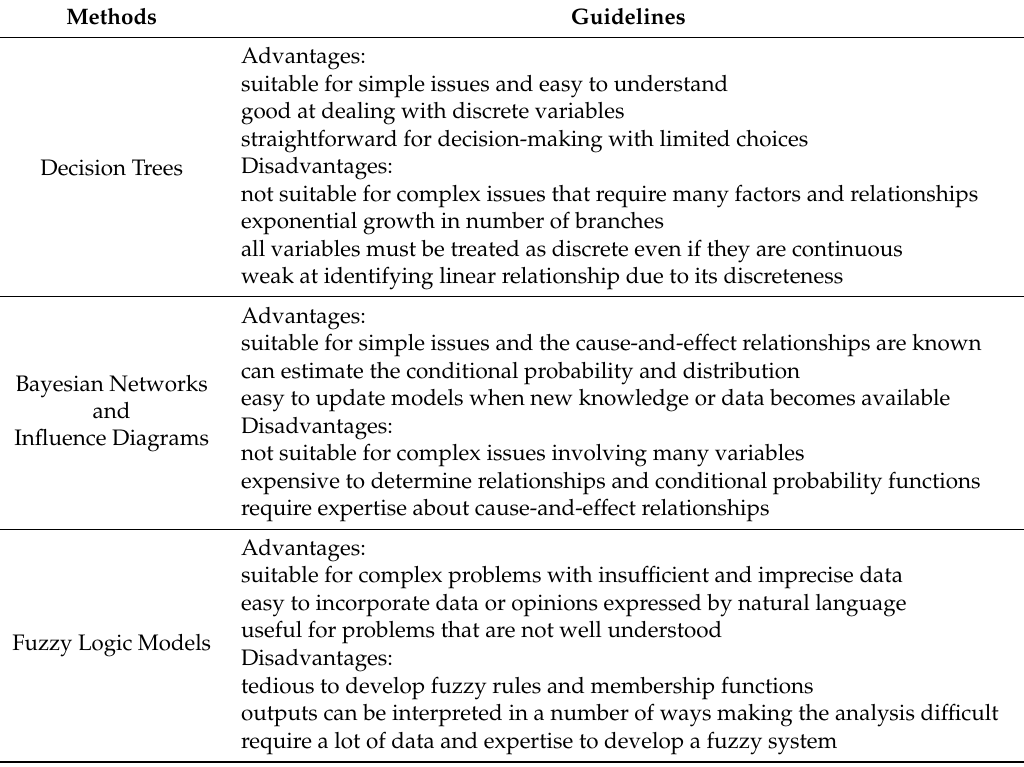
Table 3. Guidelines of Decision-making